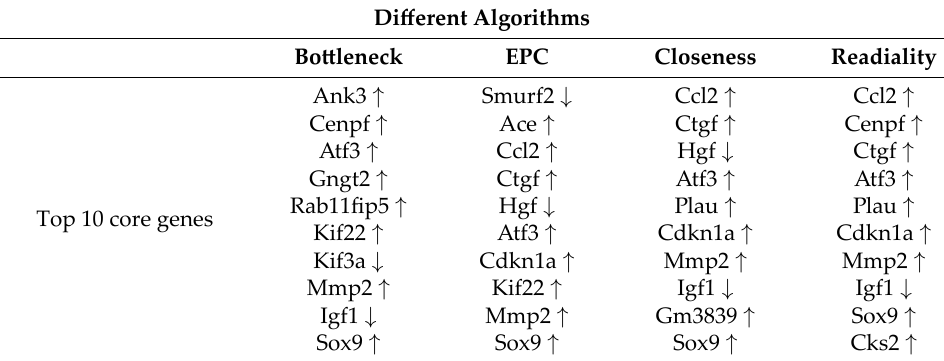
Figure 3. PPI Network Construction. Table 2. Top 10 core genes in different algorithms.